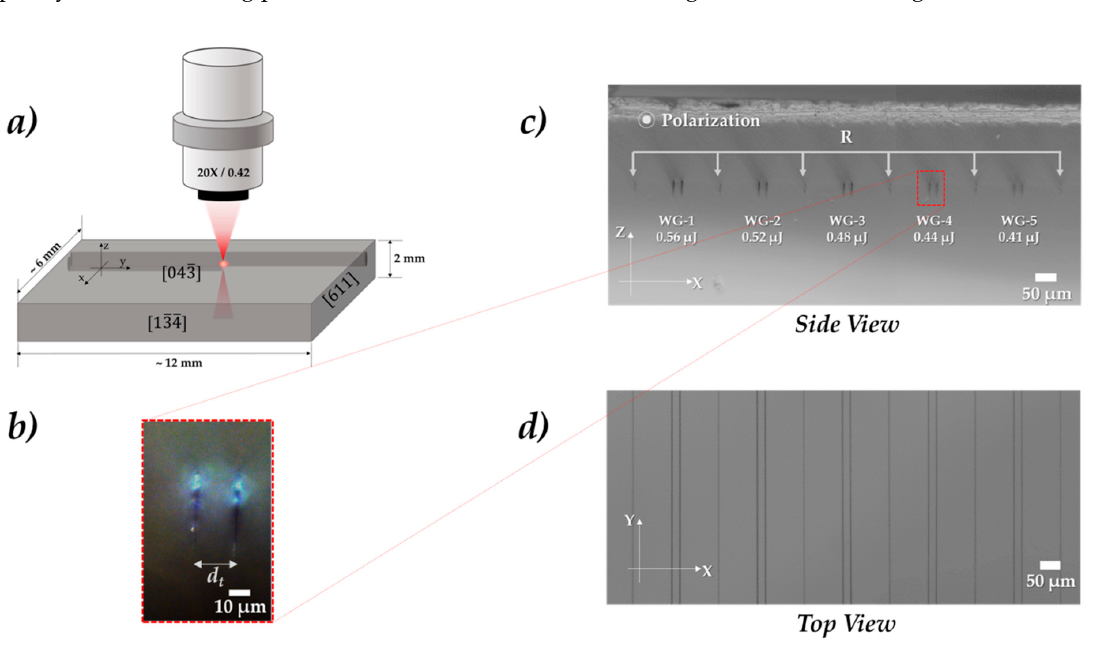
Figure 1. ( a ) Waveguide fabrication schematic of DLW process. ( b ) Dark-field (DF) microscope image Figure 1. (a) Waveguide fabrication schematic of DLW process. (b) Dark-field (DF) microscope image of a of a waveguide inscribed with a 0.44 µ J pulse energy. d t is the distance between adjacent tracks, waveguide inscribed with a 0.44 μ J pulse energy. d t is the distance between adjacent tracks, which is set at 20 μ m. which is set at 20 µ m. ( c ) side (xz-plane) and ( d ) top (xy-plane) view transmission bright-field (BF) (c) side (xz-plane) and (d) top (xy-plane) view transmission bright-field (BF) microscope images of all the double- microscope images of all the double-track waveguides and reference single tracks (R) inscribed to locate track waveguides and reference single tracks (R) inscribed to locate the double-tracks. the